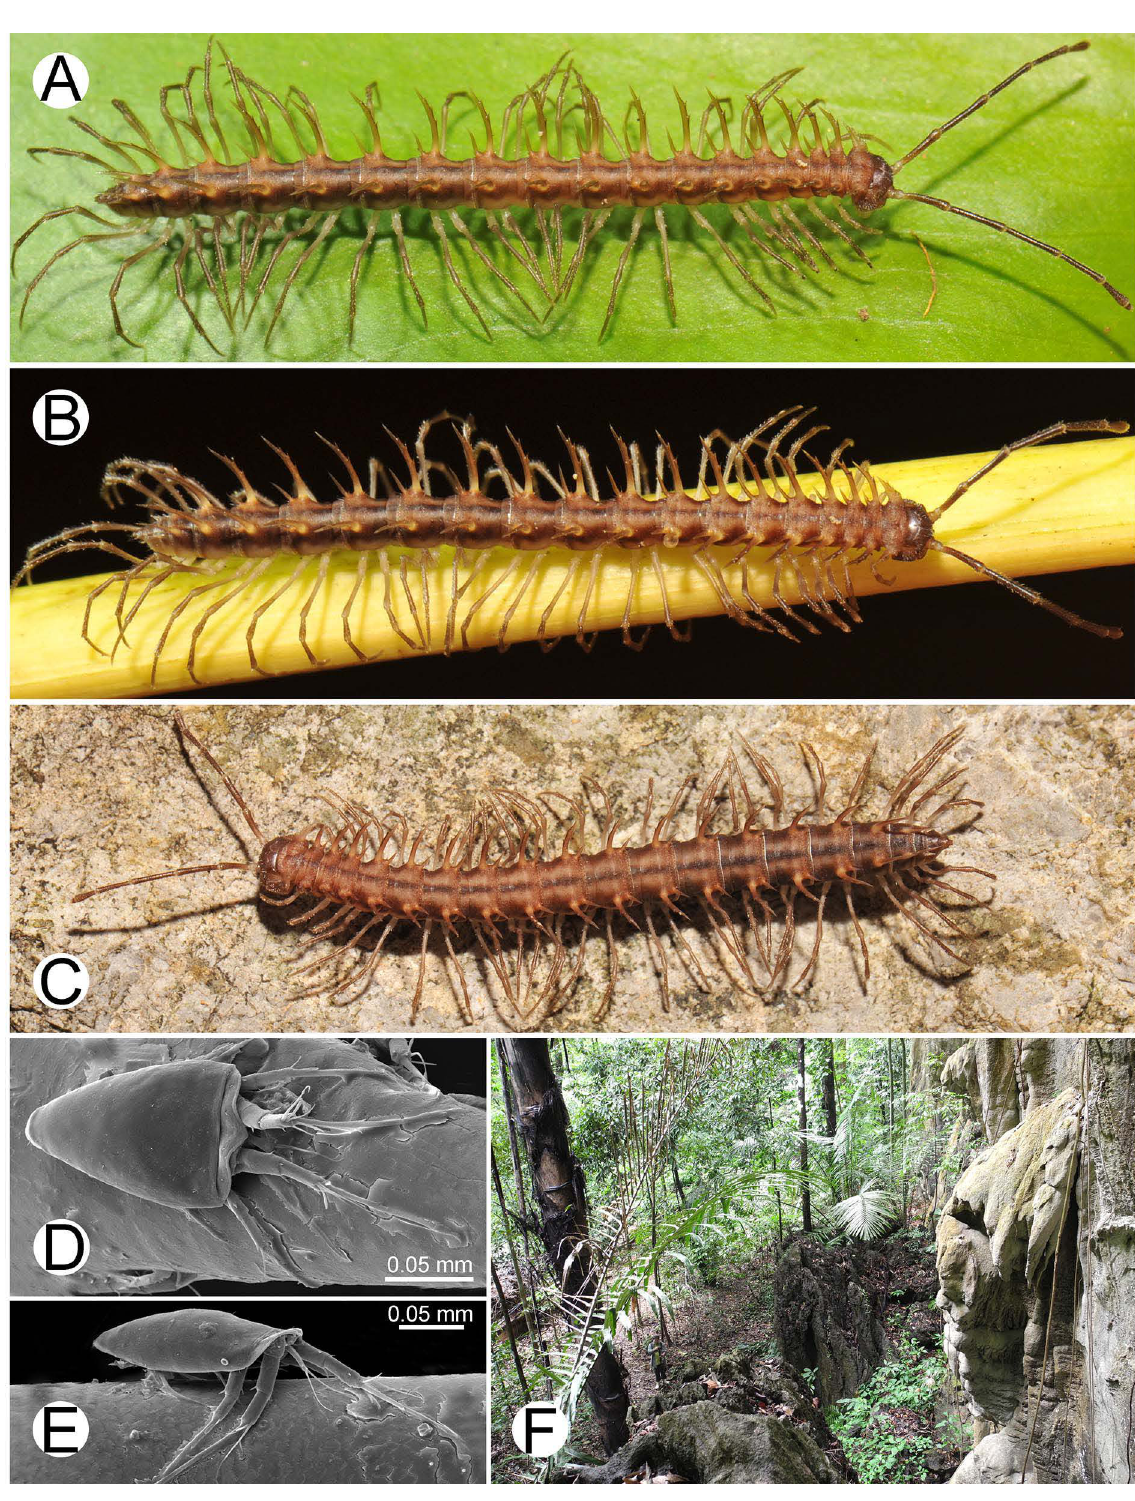
Fig. 4. A – C . Photographs of live Gigaxytes fusca Srisonchai, Enghoff & Panha gen. et sp. nov. A . ♂ paratype, specimen from Phitsadarn Cave. B . ♂ paratype, specimen from Phrayarhtan Cave (Buddha Cave). C . ♀ paratype, specimen from Phitsadarn Cave. D – E . Phoretic histiostomatid mites. F .